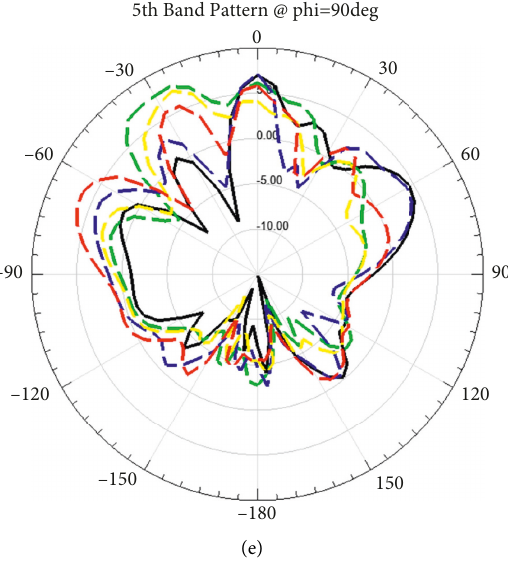
Figure 9: The H-plane gain pattern of the optimized antenna at various fabric substrates.